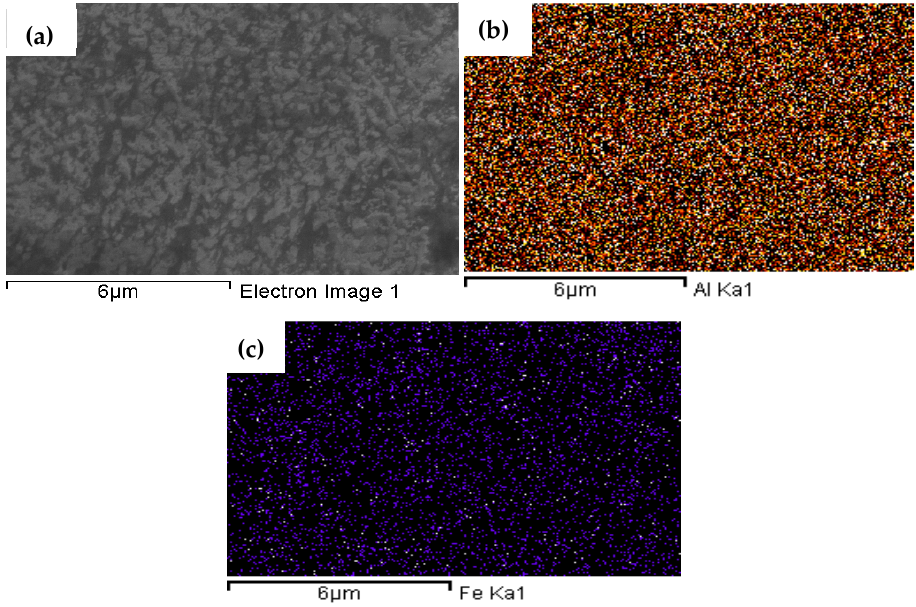
Figure 6. ( a ) EDS mapping of Al-10 wt.% Fe sintered sample, ( b ) elemental mapping showing location and presence of Al, and ( c ) elemental mapping showing location and presence of Fe.